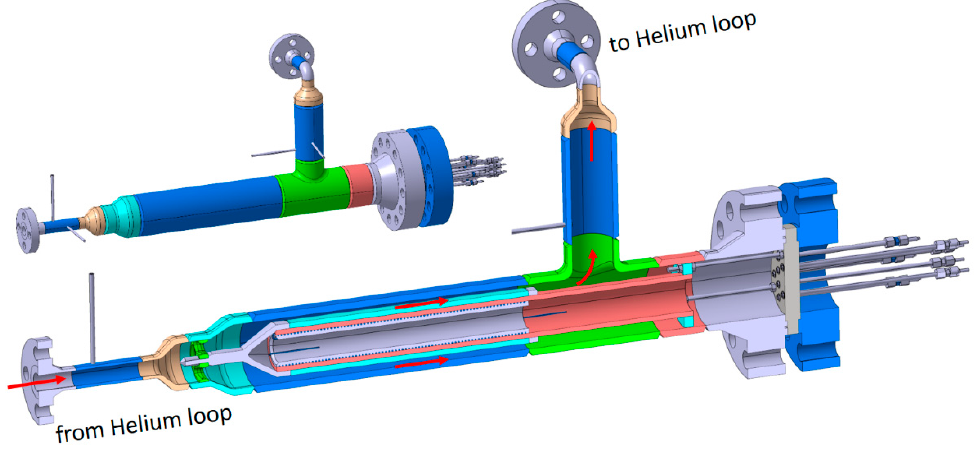
Figure 3. CAD of Figure 3. CAD of mockup.